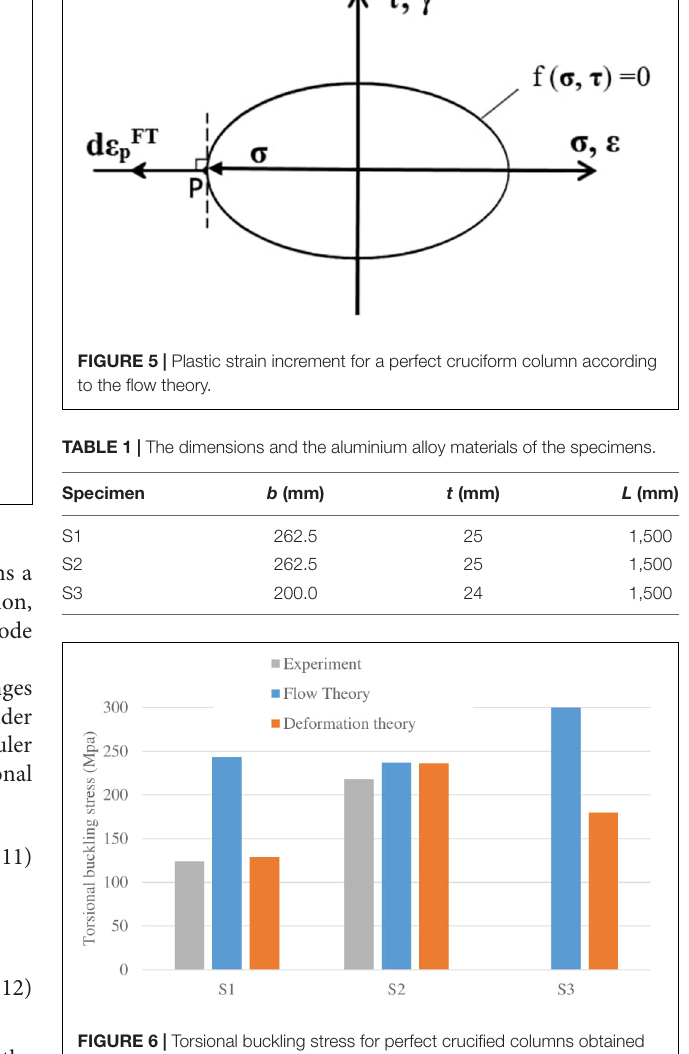
FIGURE 6 | Torsional buckling stress for perfect crucified columns obtained using the flow and deformation theories of plasticity vs test results (Guarracino and Simonelli,